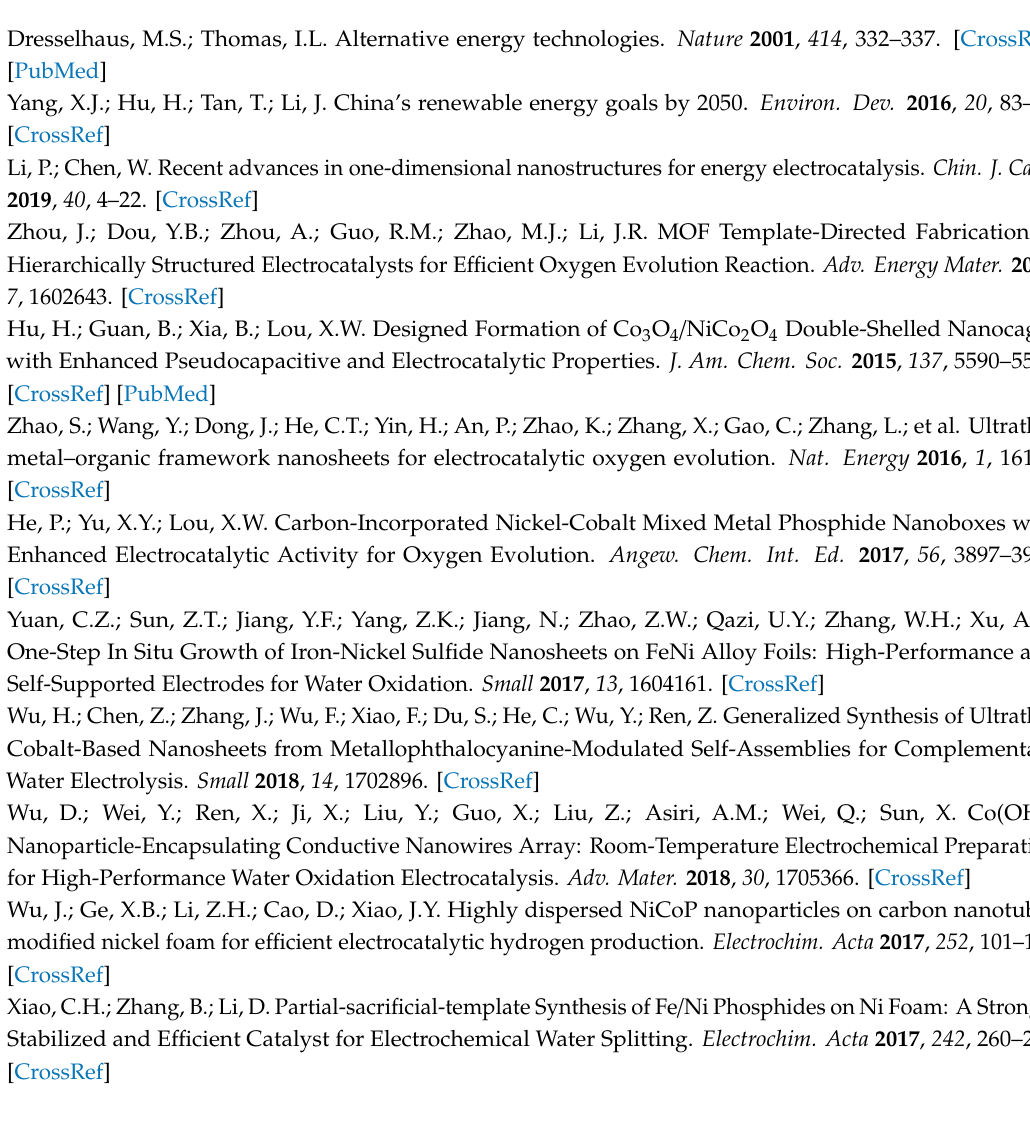
(A) and corresponding Cdl (B), Figure S13: CVs of MoS 2 :NiO 1:1 (A) and corresponding Cdl (B), Figure S14: EIS curves of NiO / MoS 2 / NF at di ff erent overpotential from 100~300 mV, Figure S15: LSV curves for NiO / MoS 2 / NF under various electrophoresis time, Figure S16: LSV curves for NiO / MoS 2 / NF before and after 500 CV cycle (left); Stability test of the NiO / MoS 2 / NF electrode at a fixed current density of 10 mA / cm 2 for HER, Figure S17: CV curves for NiO / MoS 2 / NF, Figure S18: Optimized structures of MoS 2 with zigzag edge (a) and the hybrid MoS 2 / NiO(111) (b, side view). Color modes: yellow for S, green for Mo, red for O and cyan for Ni, Table S1: The Overpotential of di ff erent electrodes at 10 and 50 mA / cm 2 , Table S2: A representative summary of HER performances of nonprecious materials based electrocatalysts previously reported catalyst for HER in 1M KOH aqueous